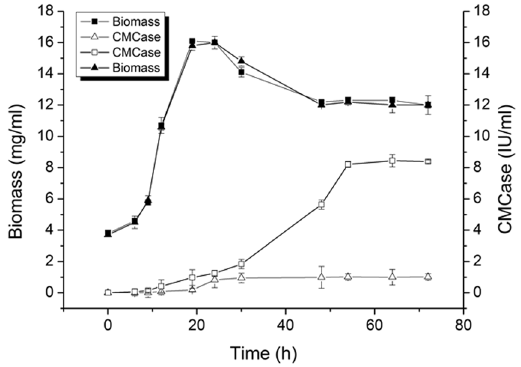
Figure 3. Changes of biomass and CMCase activity of engineering strain Bacillus subtilis Y106OE-EG and Y106-WT during liquor fermentation of 72 h in shaker flash culture (300 ml). ■ biomass of Y106OE-EG, □ CMCase activity of Y106OE-EG, ▲ biomass of Y106-WT, △ CMCase activity of Y106-WT.